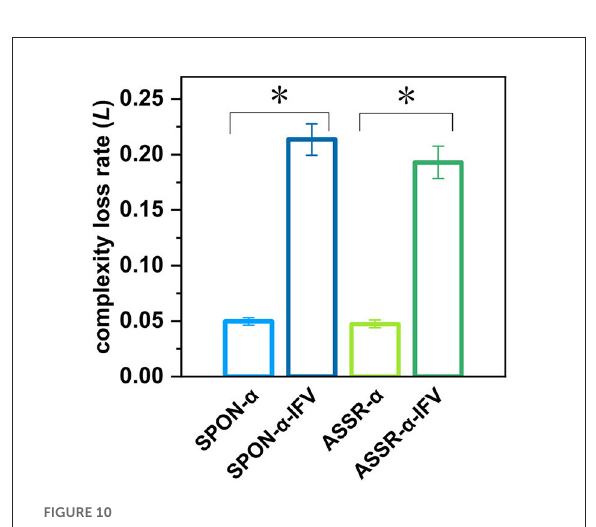
FIGURE10 Complexity loss rates of SPON- α , ASSR- α , SPON- α -IFV, and ASSR- α -IFV from all subjects and channels. See Section 2.5 for the definitions of terms. The sign * indicates significance at p <